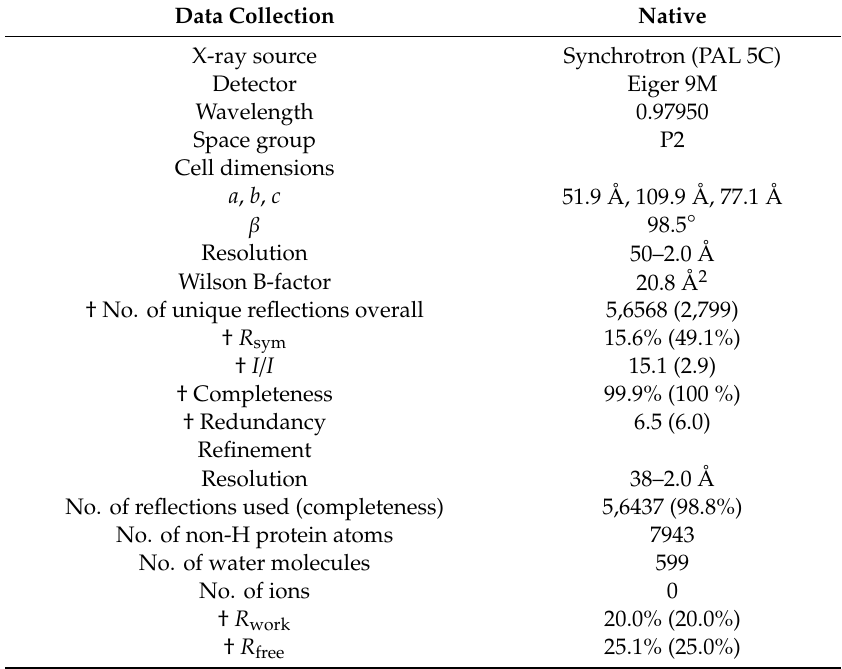
Figure 1. Crystal structure of Osm1 R326A: ( a ) Domain boundary of Osm1; the range of amino acid residues that were used for the structural study is indicated by a black triangle; ( b ) crystal structure of Osm1 R326A; two molecules in an asymmetric unit are presented with the cartoon model; ( c ) structural superposition of the two molecules in the same asymmetric unit; ( d ) the structure of Osm1 R326A depicted with rainbow color; the structure from the N- to C-terminus is colored from blue to red; two distinct domains are indicated; ( e ) MALS profile; experimentally calculated molecular mass is indicated by a red line. Table 1. Crystallographic